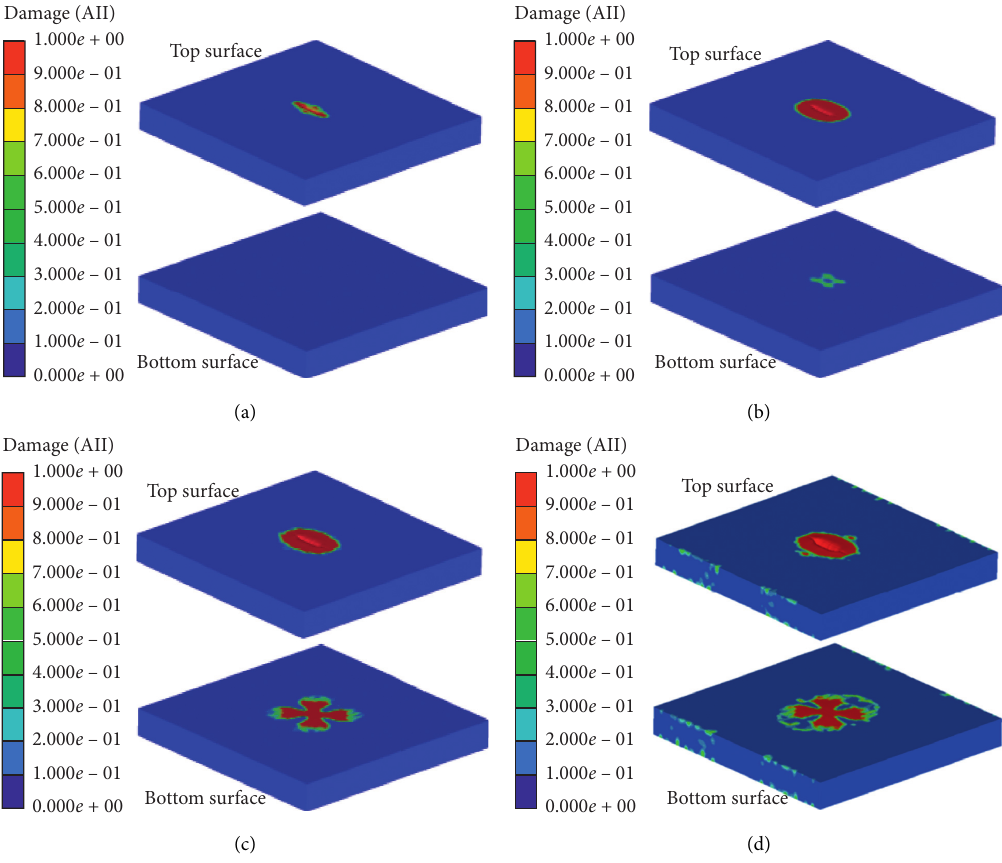
Figure 24: The damage processes of the RC slab under cylindrical explosive. (a) t � 0.01ms. (b) t � 0.02 ms. (c) t � 0.05ms. (d) t � 0.20ms.